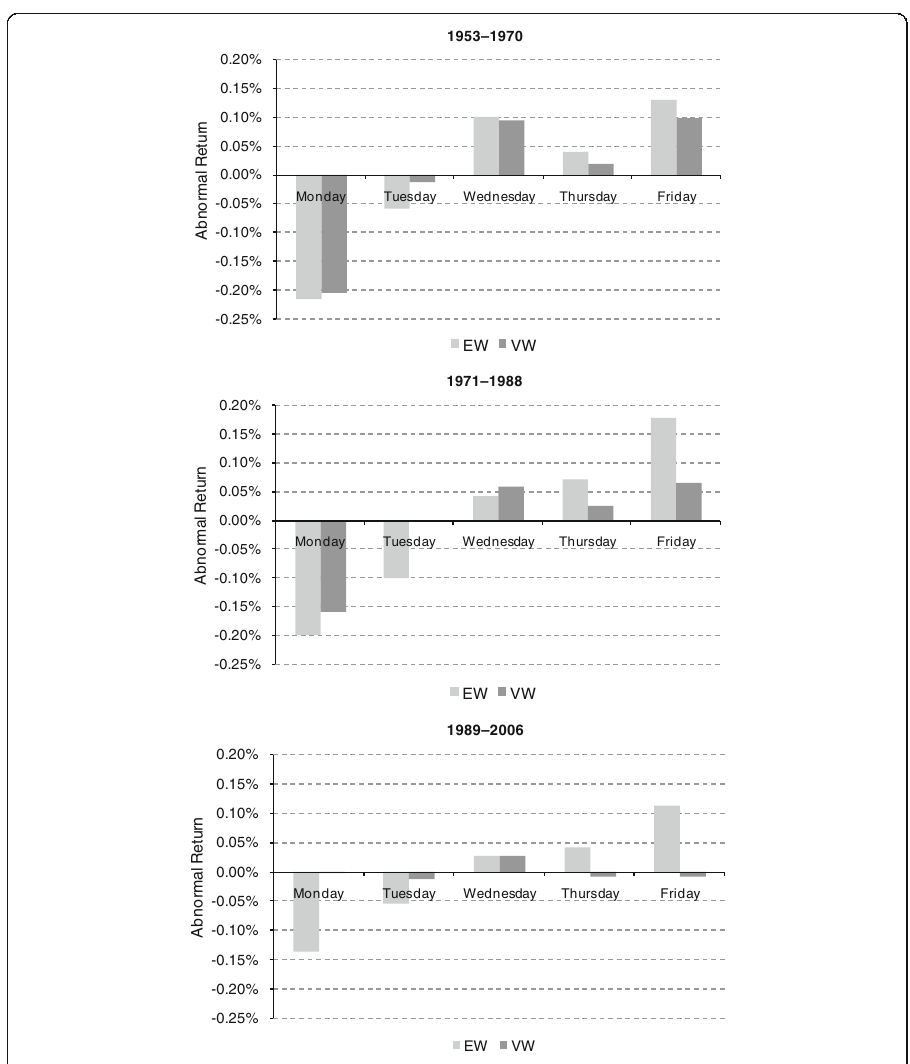
Fig. 2 Day-of-the-week effect for the EW and VW portfolios in three